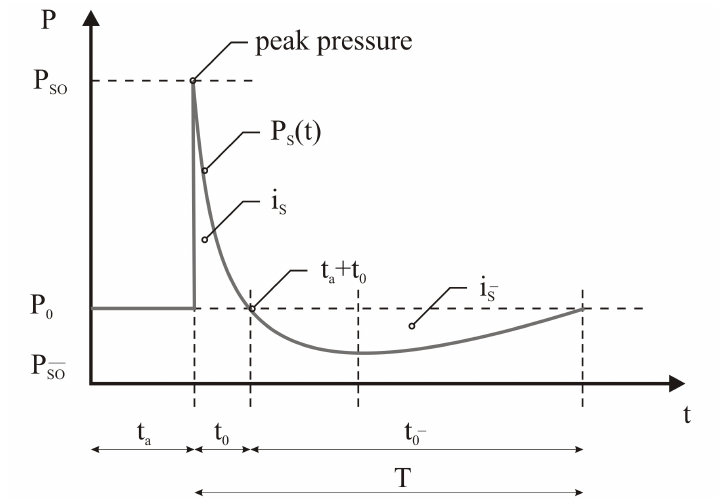
Figure 1. Overpressure versus time diagram for detonation in free air